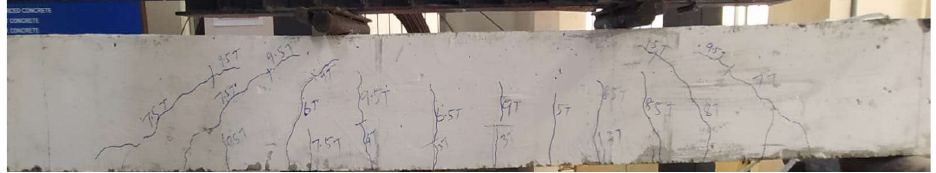
Figure 11. WWM 10 mm square reinforced LWC beam.